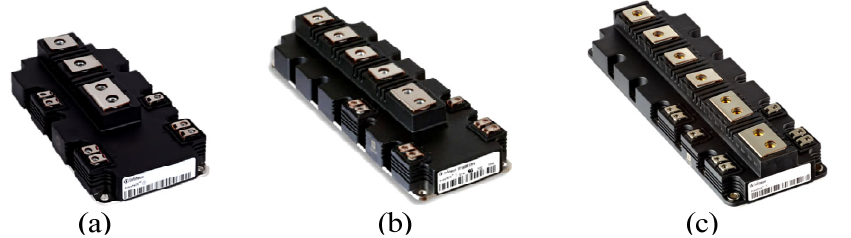
Figure 7. External appearance of the series of PrimePACK of Infineon. ( a ) PrimePACK 2. ( b ) PrimePACK 3. ( c ) PrimePACK